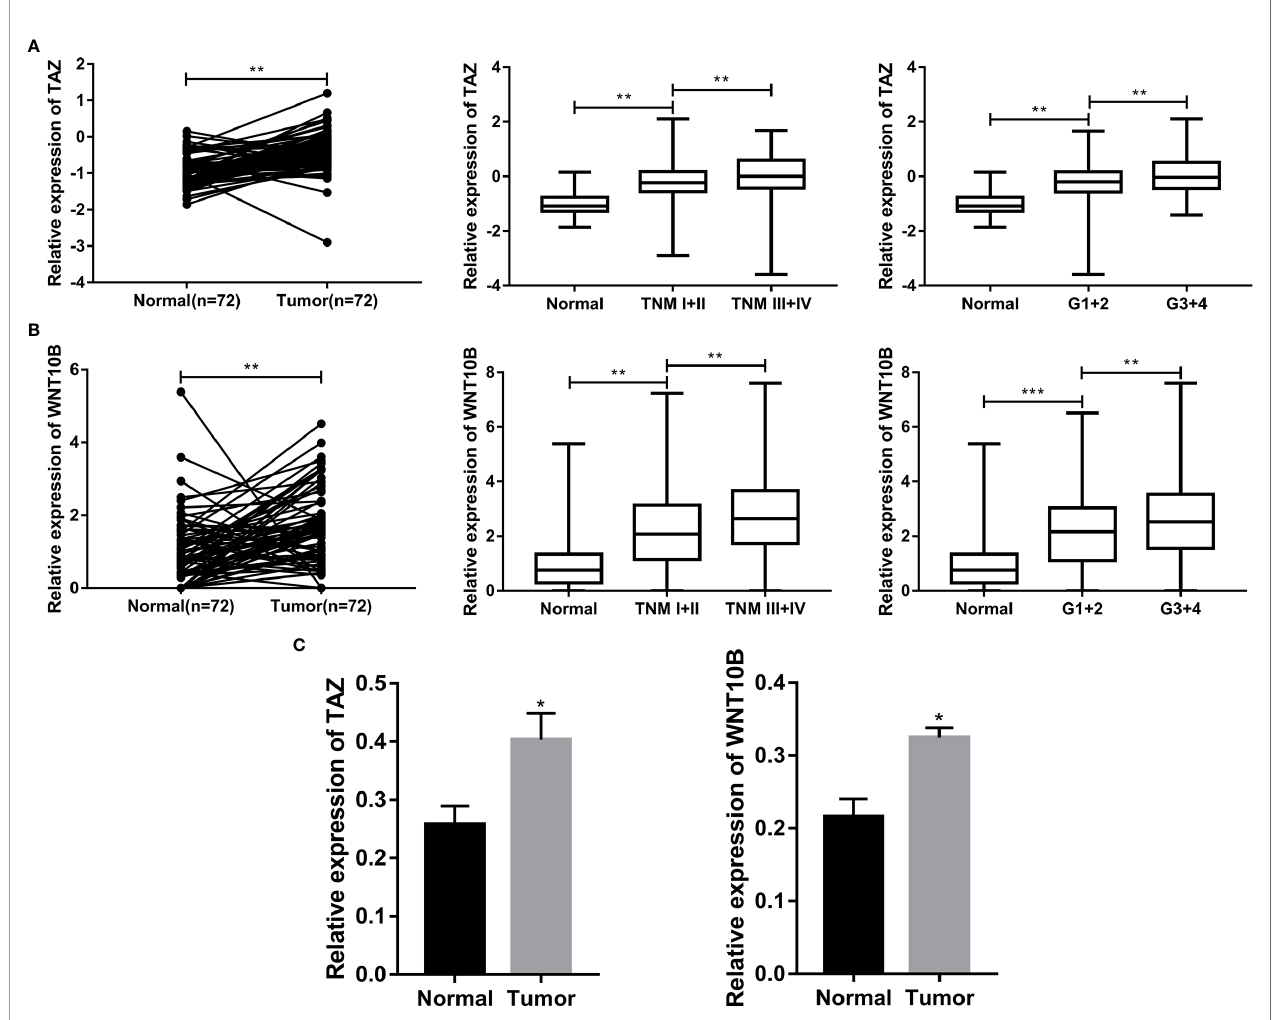
FIGURE 9 | TAZ/WNT10B was closely correlated with TNM/Grade stage and up-regulated in ccRCC tissue. (A) In TCGA-KIRC dataset, TAZ was elevated in ccRCC and positively correlated with TNM/Grade stage. (B) In TCGA-KIRC dataset, WNT10B was elevated in ccRCC and positively correlated with TNM/Grade stage. (C) The mRNA expression level of TAZ/WNT10B was upregulated in ccRCC tissues. ccRCC, clear cell renal cell carcinoma. ***P < 0.001; **P < 0.01; *P <